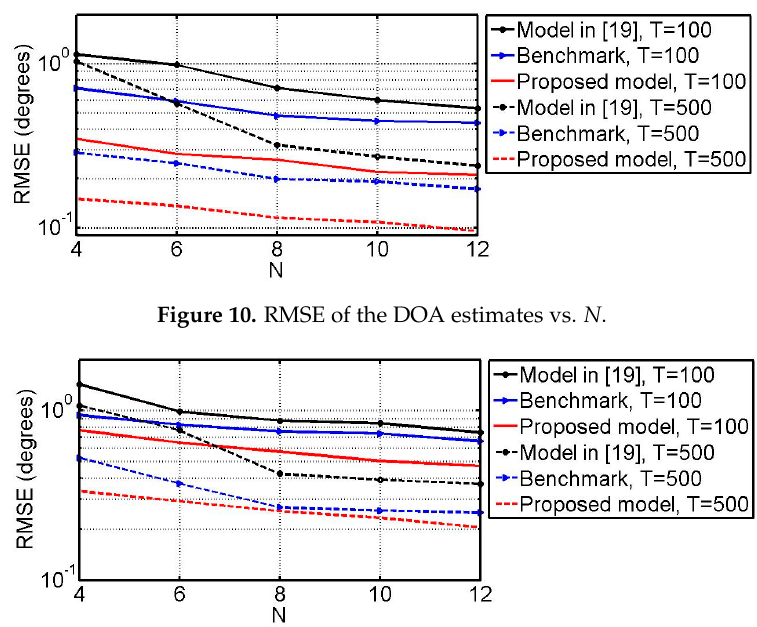
Figure 9. DOF vs. N .